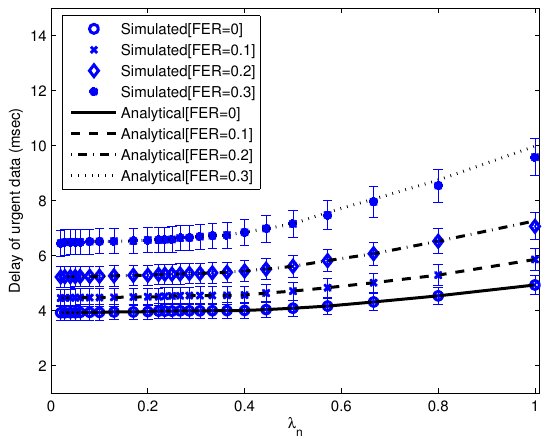
Figure 5. The average delay of urgent data vs . λ n . ( λ u = 66.6 frames/s per node). SIFS, short inter-frame space; MIFS, medium IFS; LIFS, long